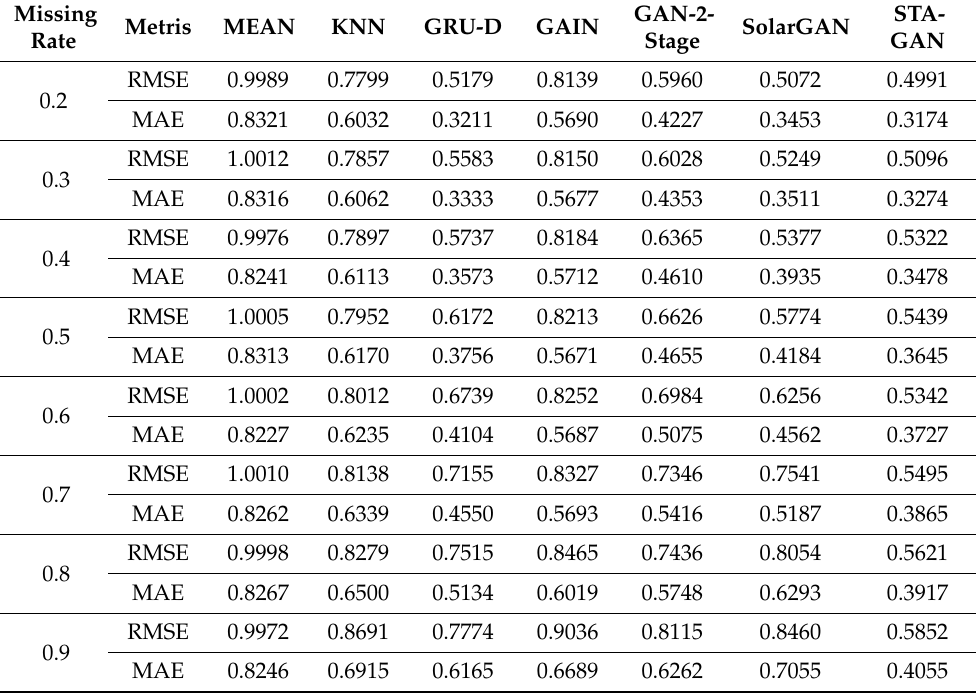
Table 2. The results (RMSE and MAE) of SST-SOUTH dataset with different missing rates.